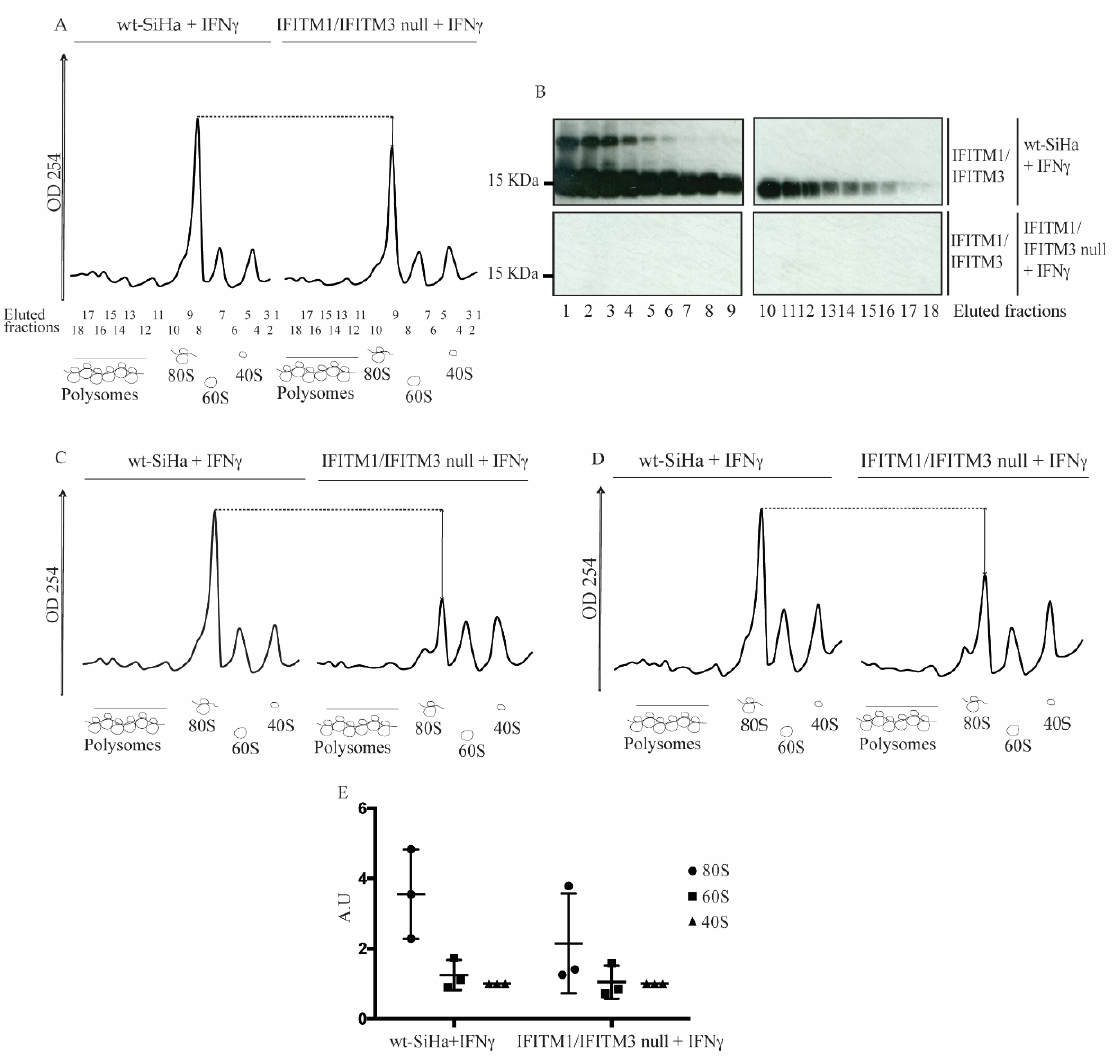
Figure 5. Ribosomal integrity analysis in IFN γ -stimulated wt-SiHa cells and IFITM1/IFITM3 null cells. ( A , C , D ). The wt-SiHa cells and IFITM1/IFITM3 null cells were stimulated in three biological replicates with 100 ng/mL IFNγ for 24 h. The cells were lysed with ribosome stabilization buffer and applied to a 10–45% sucrose gradient to separate individual components of the large and small ribosomal subunits and polysomal structures. Eluted fractions (numbered) were scanned at A254 nm, and the diagram highlights the position of the 40S, 60S, 80S, and polyribosomal subunits. The dotted line highlights the reproducible reduction in the A254 signal in eluates from the IFITM1/IFITM3 null cells. ( B ) Following fractionation of material from ( A ), samples from fractions 1 – 18 were precipitated by trichloroacetic acid, and they were analyzed for IFITM1/3 protein expression (enriched in all wt-SiHa fractions). ( E ) Quantitation of the ratio of 40S, 60S, and 80S A254 nm peaks in wt-SiHa cells and IFNγ -stimulated IFITM1/IFITM3 null cells.